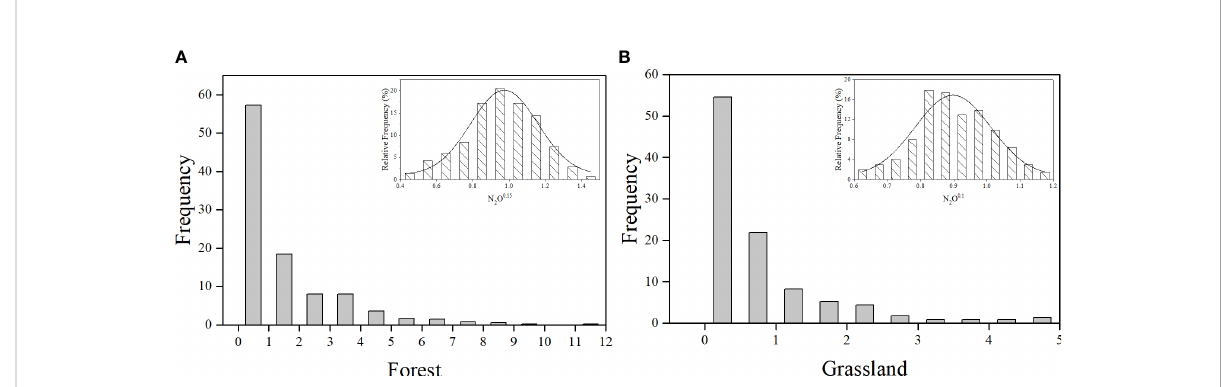
FIGURE 2 Frequency histogram of N 2 O emissions in forest (A) and grassland (B) . The subgraph in the upper right is the distribution of N 2 O emissions after BOX-COX transformation.